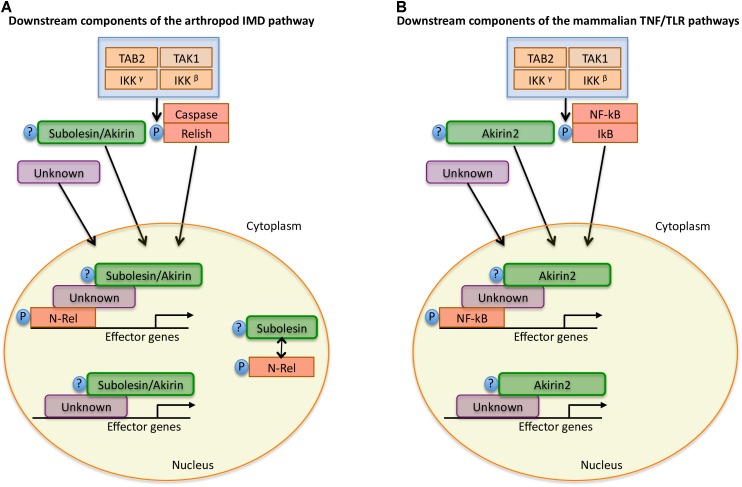
Model for Subolesin/Akirin function in immune response pathways. A simplified annotation of the downstream components of the arthropod IMD and mammalian TNF/TLR pathways (Goto et al., 2008; Beutler and Moresco, 2008; de la Fuente et al., 2008; Naranjo et al., 2013; Shaw et al., 2017). (A) After activation of the arthropod IMD pathway, the TGF-β (TAK1), Tak1-binding protein 2 (TAB2) and the I-KB kinase (IKK) complex are recruited, which leads to phosphorylation of the NF-κB transcription factor, Relish. After phosphorylation, the N-terminal domain of Relish (N-Rel) is cleaved by Caspase-8 homolog Dredd or a similar Caspase and is translocated to the nucleus. Subolesin/Akirin may be post-translationally modified and translocated to the nucleus. In the nucleus, N-Rel interacts with Subolesin/Akirin through unknown proteins to drive the production of anti-microbial peptides and other effector genes. In ticks, N-Rel and Subolesin may be reciprocally regulated. (B) In mammals, the activation of the TNF/TLR signaling pathways also results in the recruitment of the TAB2-TAK1 and IKK complexes, which results in the phosphorylation of the inhibitory regulator of NF-kB, IkB, resulting in the NF-kB translocation to the nucleus. As in arthropods, Akirin2 may be post-translationally modified and translocated to the nucleus. Once in the nucleus, NF-kB interacts with Akirin2 through unknown proteins for the activation of gene expression. In both arthropods and mammals, Subolesin/Akirin are involved in the regulation of genes that are Relish/NF-kB independent.